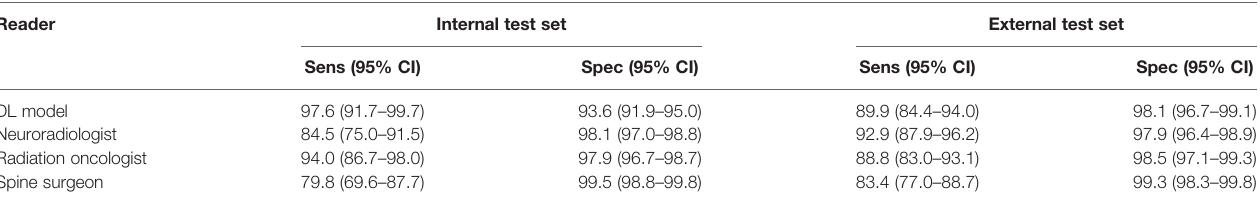
TABLE 4 | Internal and external test set sensitivity and speci fi city for the deep learning model and specialist readers using dichotomous Bilsky gradings (low versus high grade) on MRI.